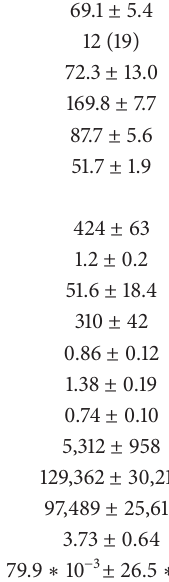
Table 1: General characteristics of the study sample and results from the six-minute walk test ( 𝑛 = 62 ). General characteristics